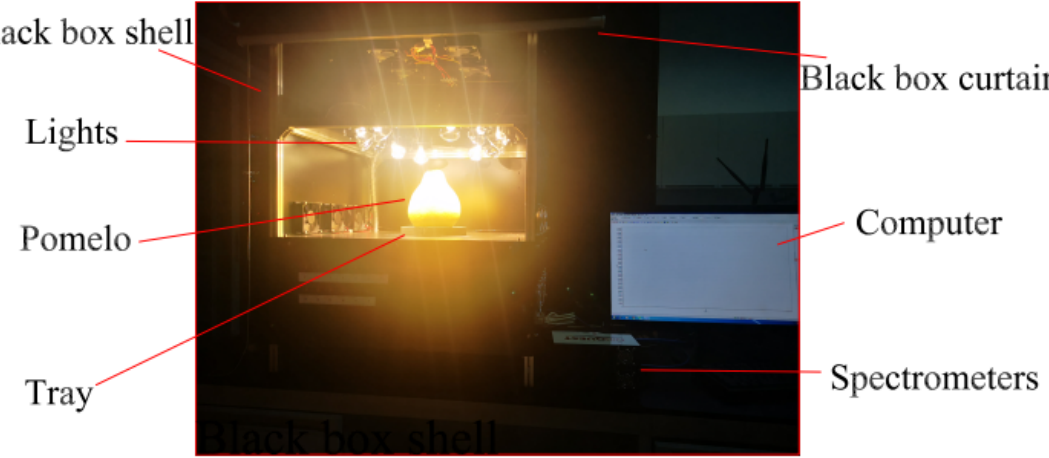
/ NIR spectrum sampling